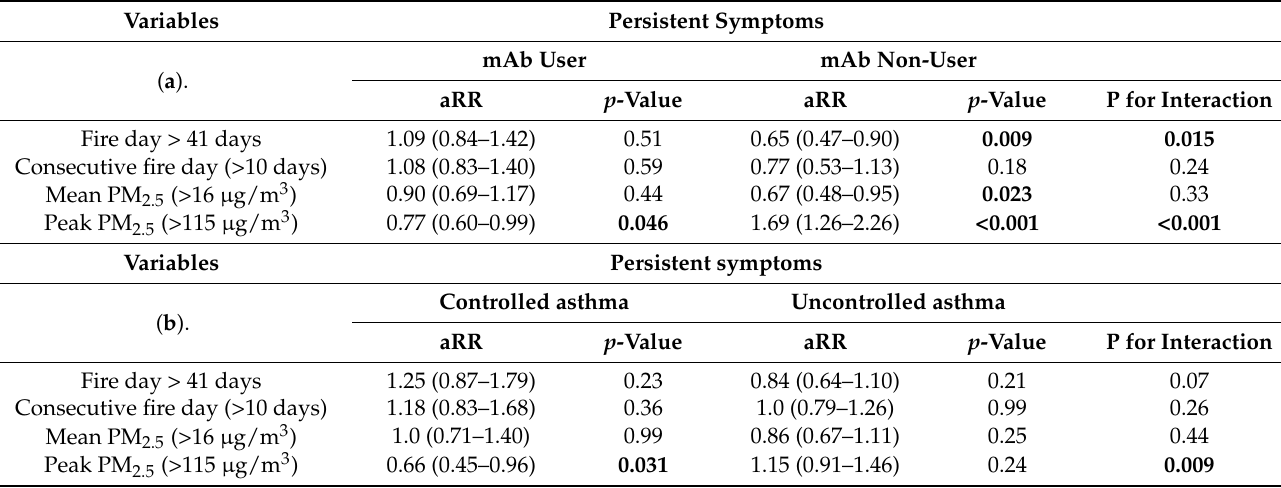
Table 5. Multivariable models for the association between persistent symptoms following the bushfire period and bushfire smoke event days/bushfire-related PM 2.5 concentrations (1 October 2019